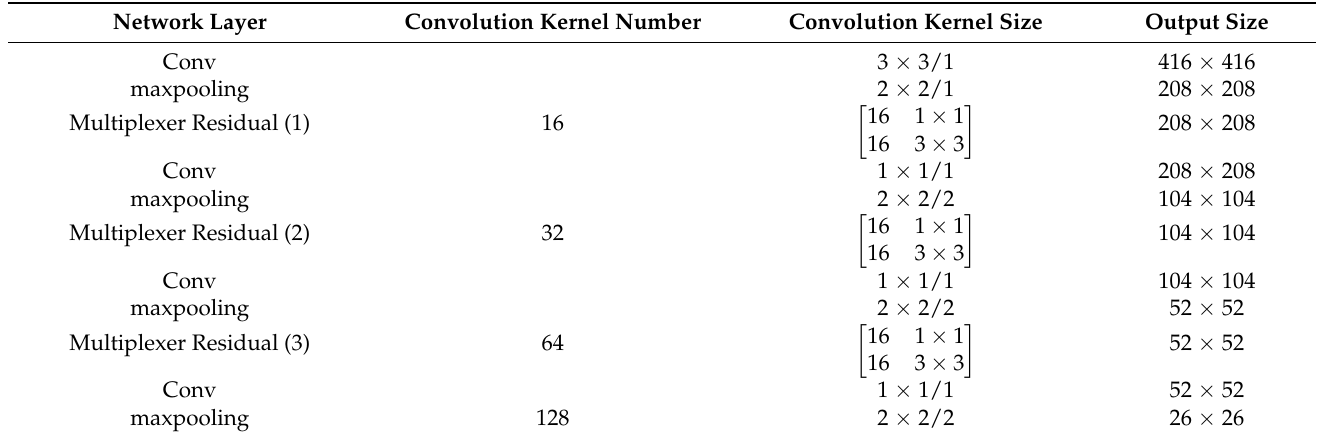
Table 1. FMRN network parameters.